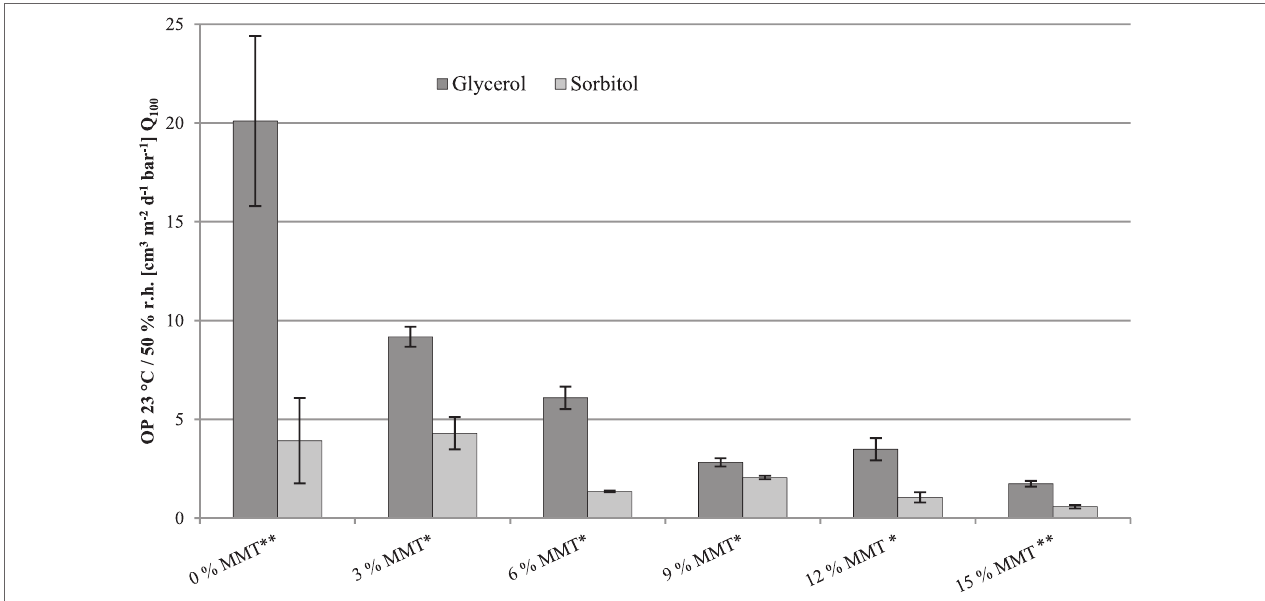
FigUre 3 | Effect of different montmorillonite (MMT) nanofiller loadings on oxygen permeability ( Q 100 ) of whey protein isolate-based (10% w/w) nanocomposite coatings with 66.70% (w/w protein) glycerol or sorbitol. *Error bars show minimum and maximum values of a twofold determination. **Error bars show SDs of a threefold